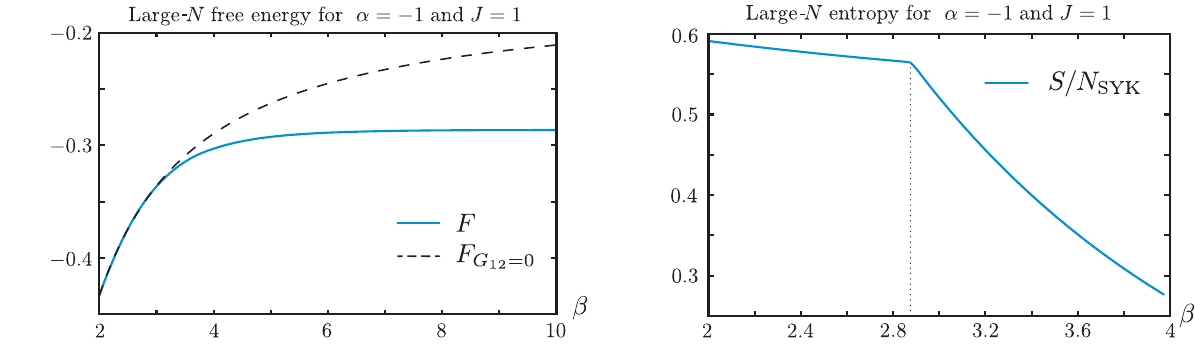
FIG. 12. Large- N free energies of the true numerical solution and the solution with G 12 ¼ 0 for α ¼ − 1 , J ¼ 1 . The graph on the right shows the entropy; we can clearly see a second-order phase transition, as there is a discontinuity in its derivative near critical temperature.